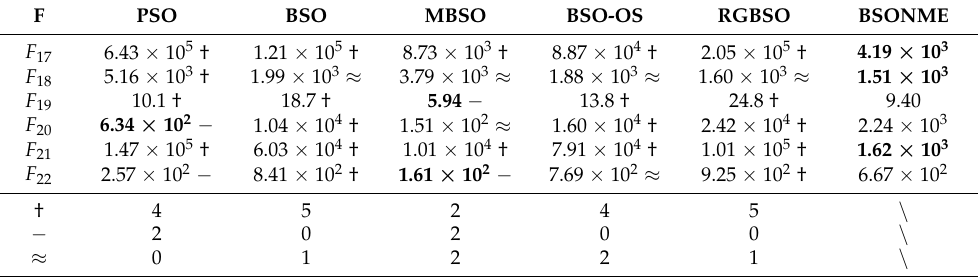
Table 9. Experimental results of PSO, BSO, MBSO, BSO-OS, RGBSO, and BSONME on F 17 – F 22 .